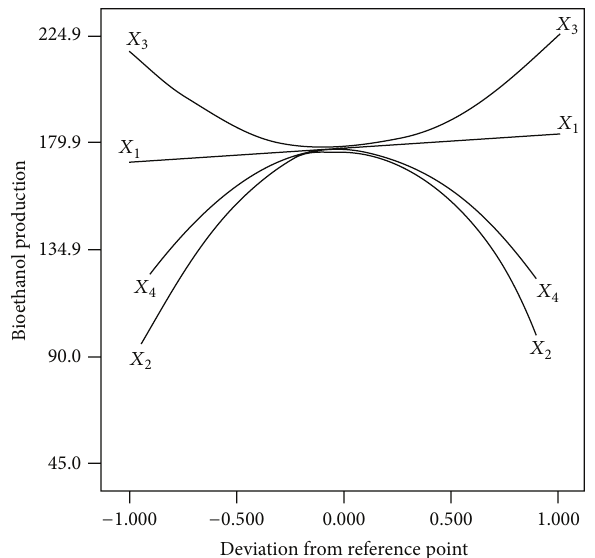
Figure 5: Perturbation plot for bioethanol